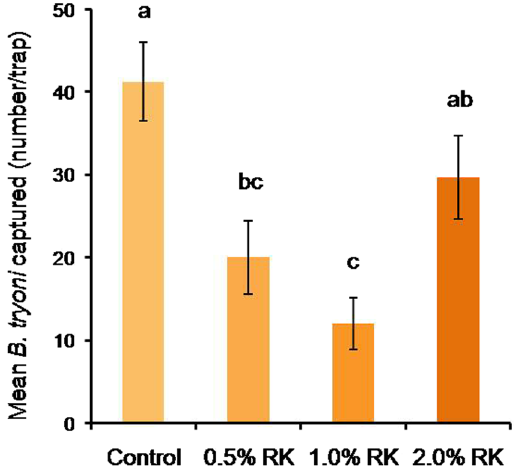
Figure 2. Effect of feeding raspberry ketone (RK) to immature sterile male B. tryoni on their recapture in cue- lure baited Lynfield traps in walk-in field cages. Means followed by the same letter are not significantly different (p > 0.05).